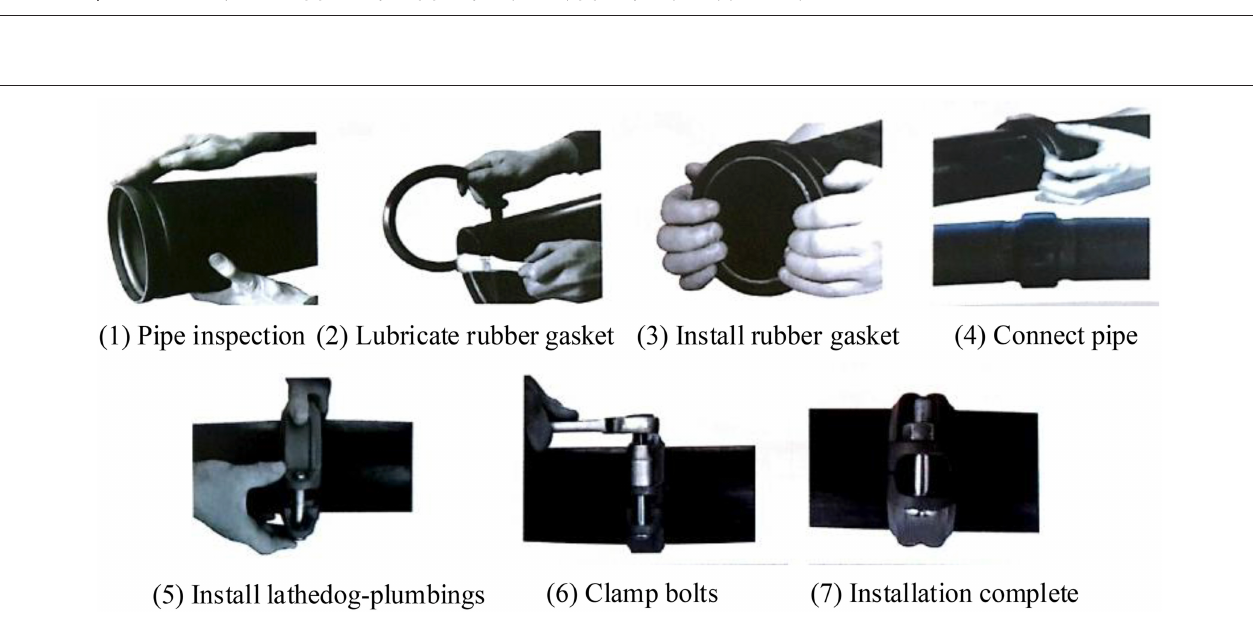
FIGURE 6 | Installation procedure of grooved fit